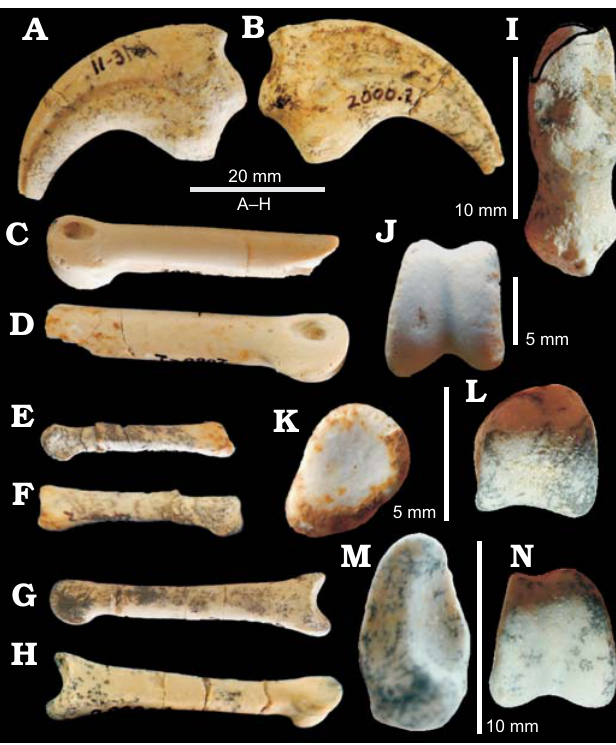
Fig. 5. Crested theropod dinosaur Elmisaurus rarus Osmólska, 1981, MPC-D 102/007 from Nemegt Formation (Upper Cretaceous), Western Sayr of Nemegt locality, Mongolia. Manual phalanges II-2 ( A , B , I ), II-3 ( C , D , J ), III-1 ( E , F , K , L ), and III-3 ( G , H , M , N ); in lateral or medial (A–H), proximal (I, K, M), and distal (J, L, N)